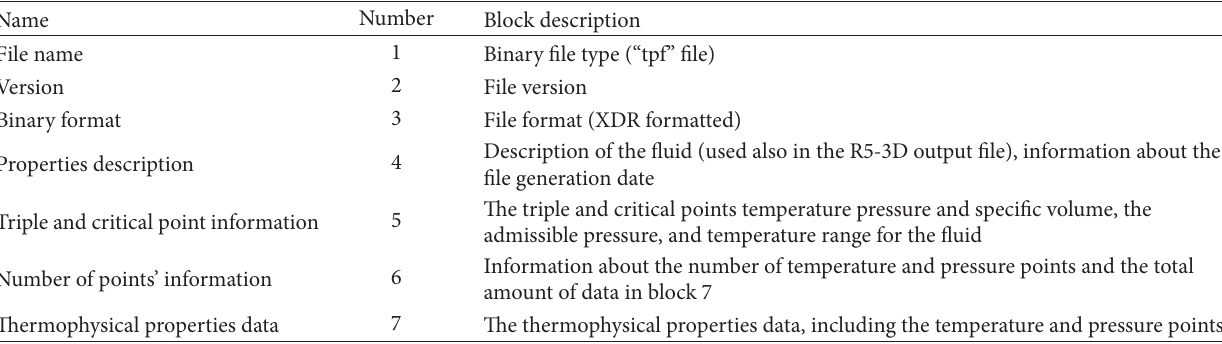
Table 1: “tpf” binary file blocks structure